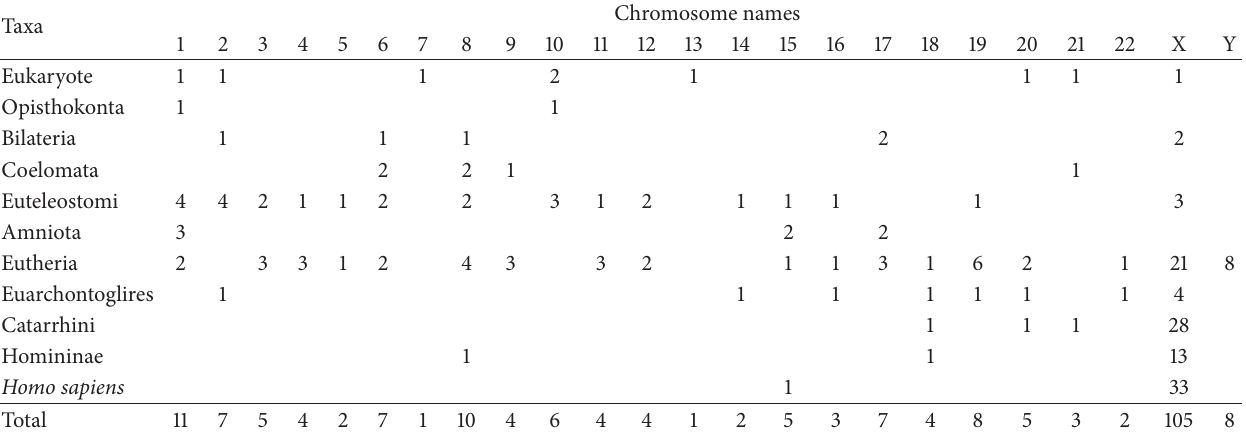
Table 1: Distribution of all human CT genes according to the origin of their orthologues in different taxa of human lineage. Taxa